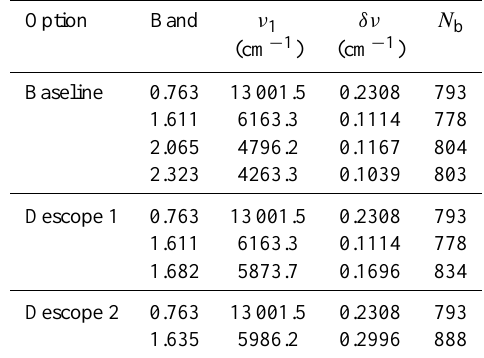
Table 4. Parameters determining the spectral